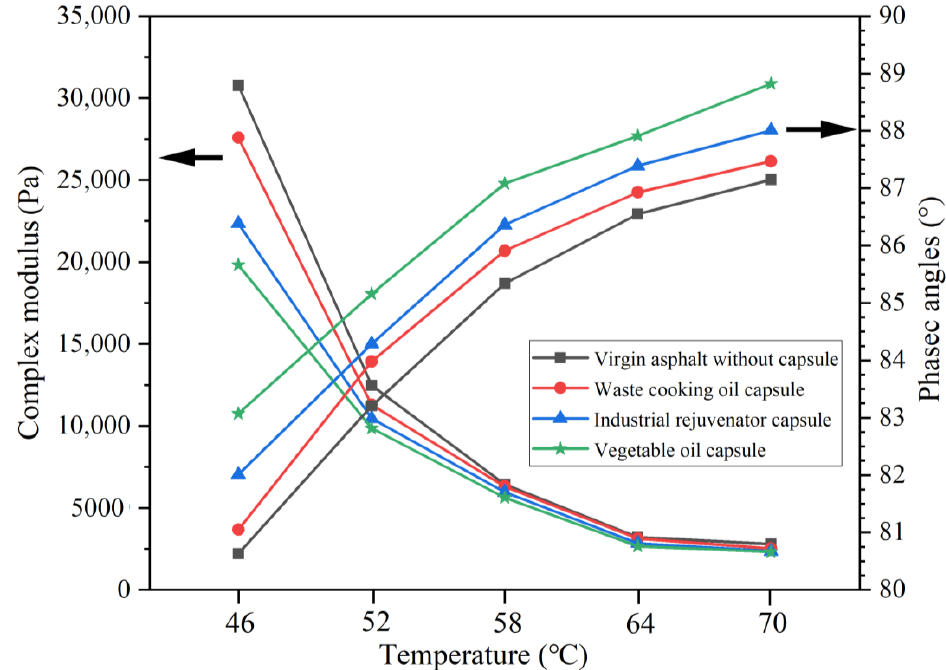
Figure 13. The G* and δ of the extracted asphalt binders within asphalt mixtures containing different capsules after loading at 0.6 MPa.